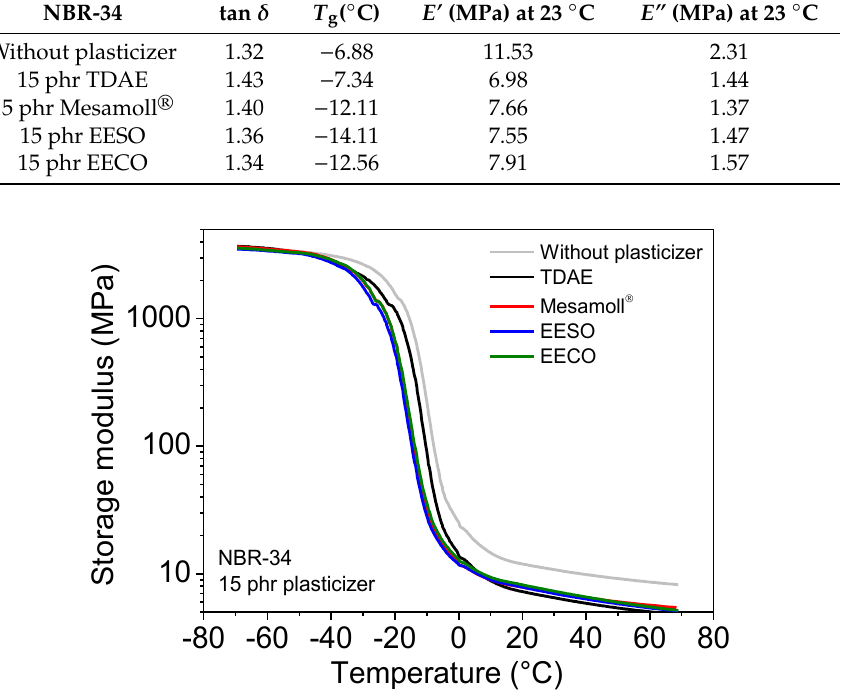
Figure 9. Storage modulus E’ of NBR-34 vulcanizates with 15 phr various plasticizers as a function of temperature.